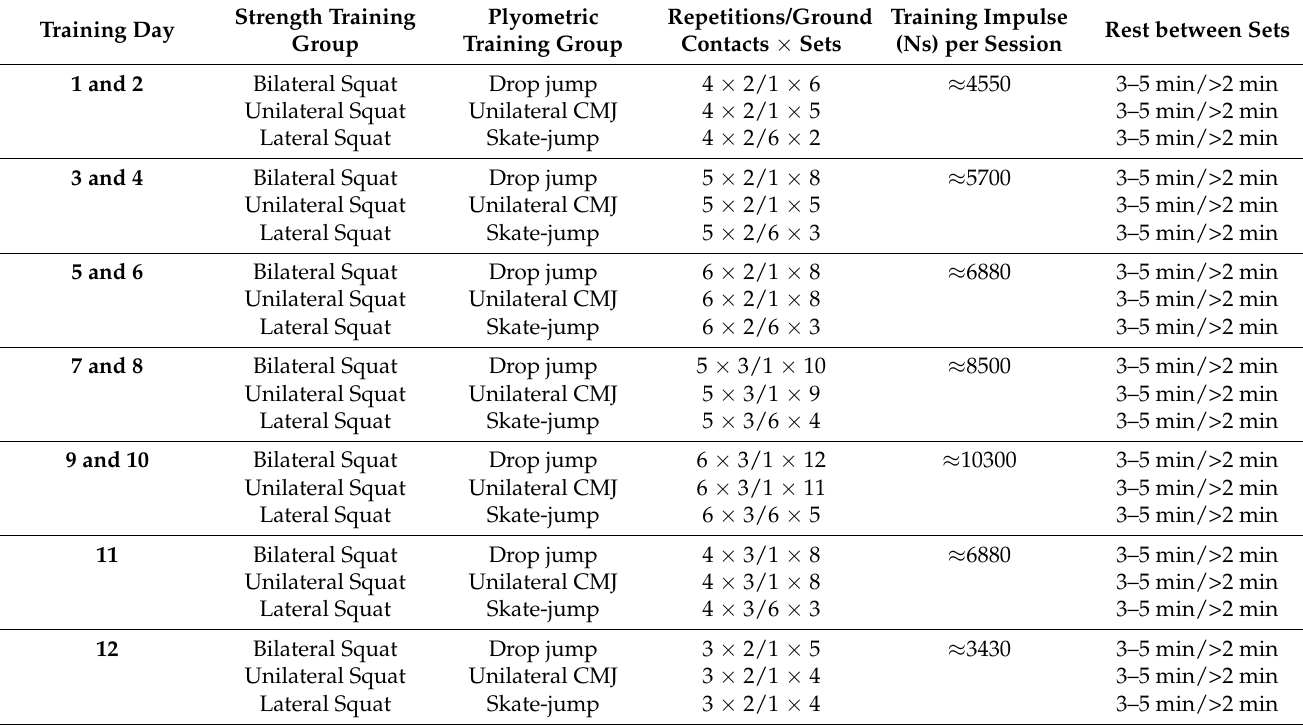
Table 2. Training program with the training impulse for the strength and plyometric group.